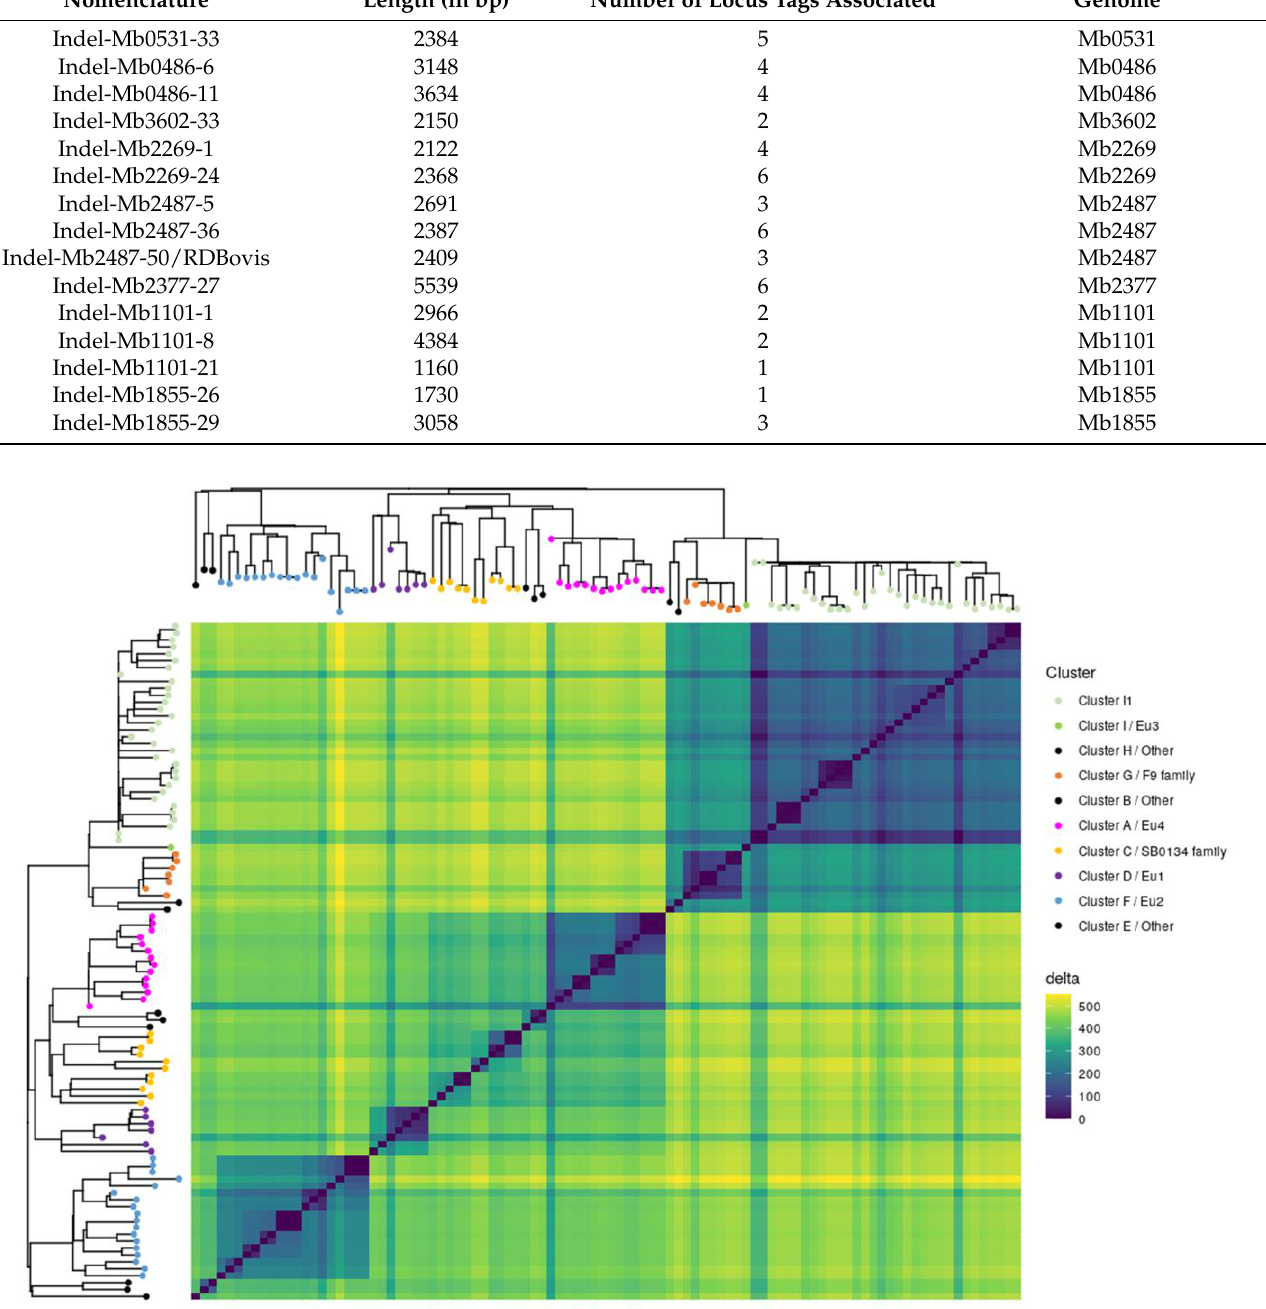
Figure 4. M. bovis isolates separated into clusters. The heatmap illustrates pairwise SNP distance between genomes belonging to each cluster. Both axes have a maximum-likelihood SNP-based tree inferred on 98 genomes with leaf colored according to cluster defined in this study. Trees were midpoint rooted. The SNP difference key is shown on the right.